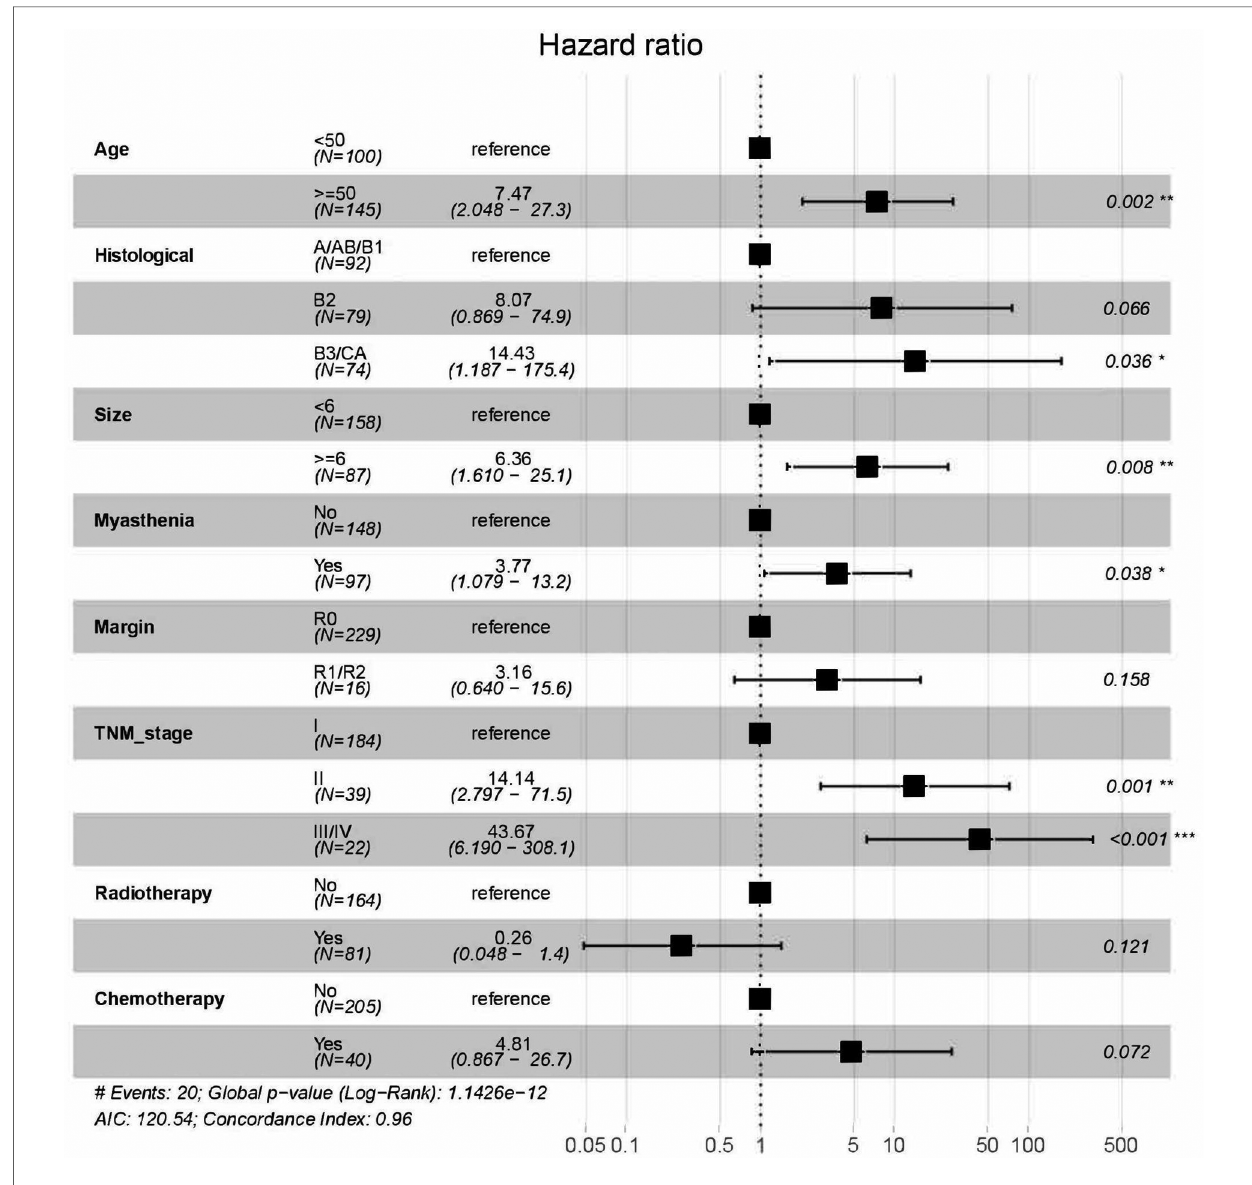
FIGURE 2 Hazard ration of variables based on multivariate cox regression model and stepwise regression based on the Akaike information